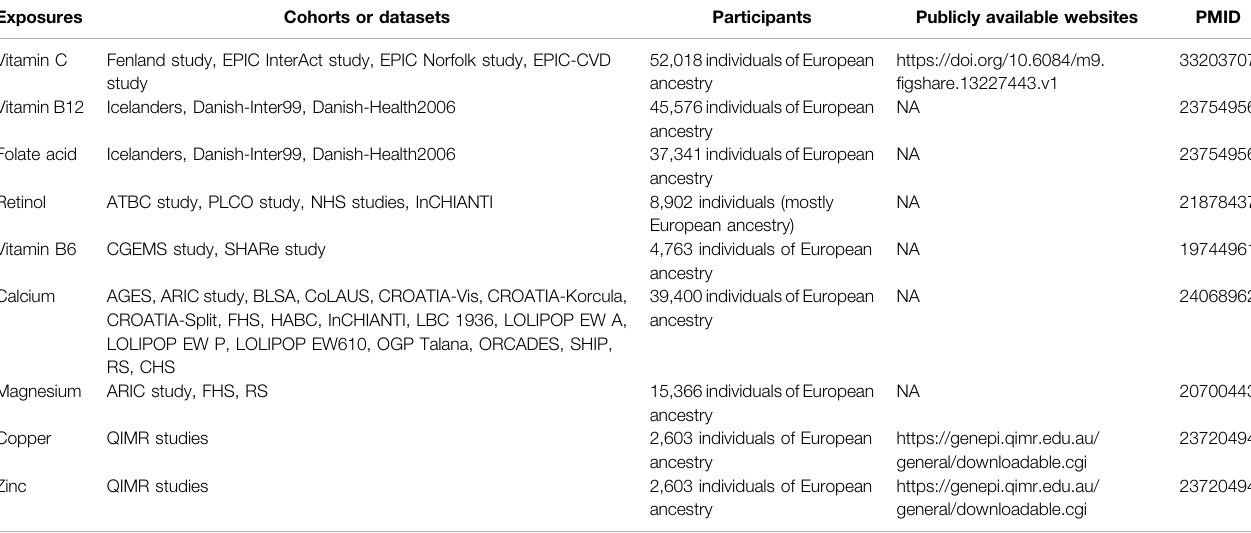
TABLE 1 | Summary of details on GWASs and related datasets involving nine micronutrients in our study.